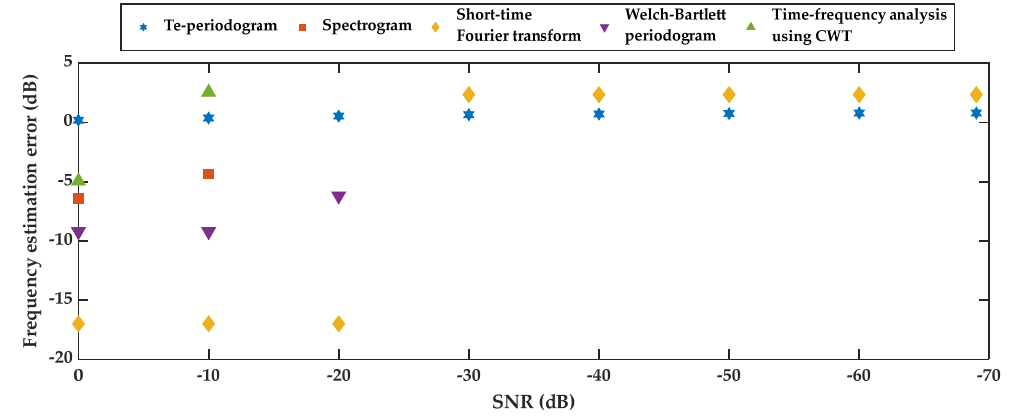
Figure 7. Frequency estimation error.